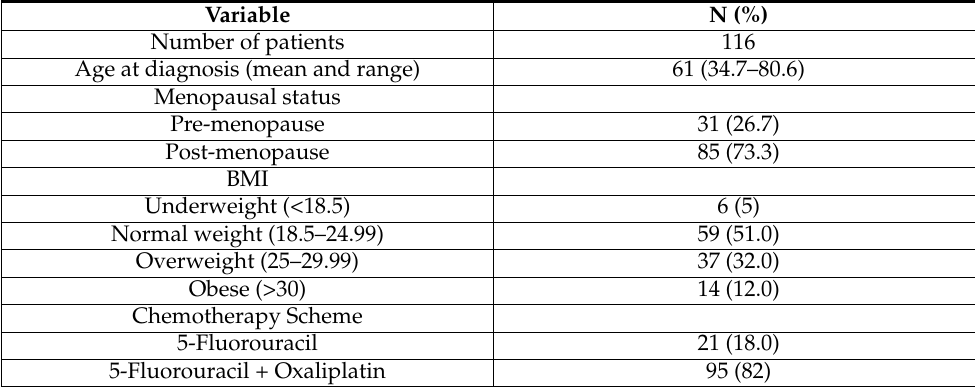
Table 2. Non metastatic, colorectal cancer patients’ clinical and pathological